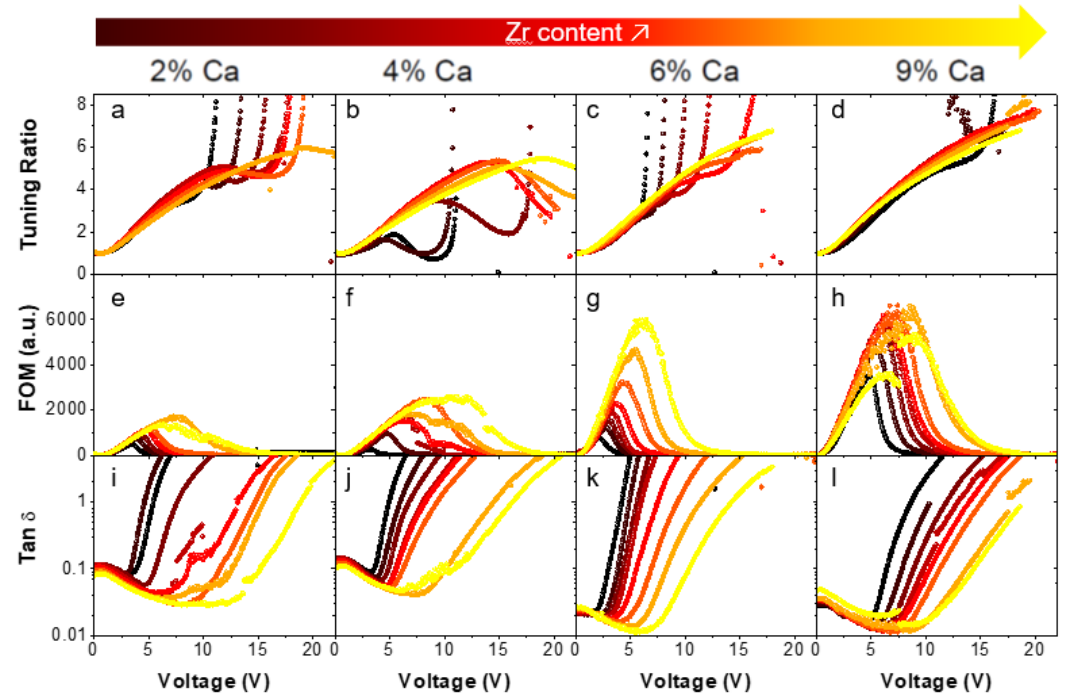
Figure 3. Tuning ratio ( a – d ), FOM ( e – h ) and Tan δ ( i – l ) vs. applied dc voltage and Zr content for different amounts of Ca. From left to right: 2%, 4%, 6%, 9% Ca. The amount of Zr increases from black (dark) to yellow (bright) in each graph.